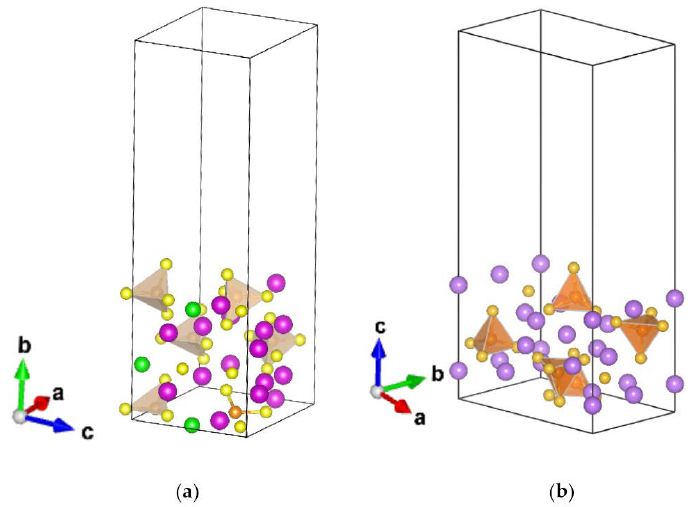
Figure 1. Slab model to study electrostatic potential at ( a ) (010) surface for Li 7 P 2 S 8 I and ( b ) (001) surface for Li 3 PS 4